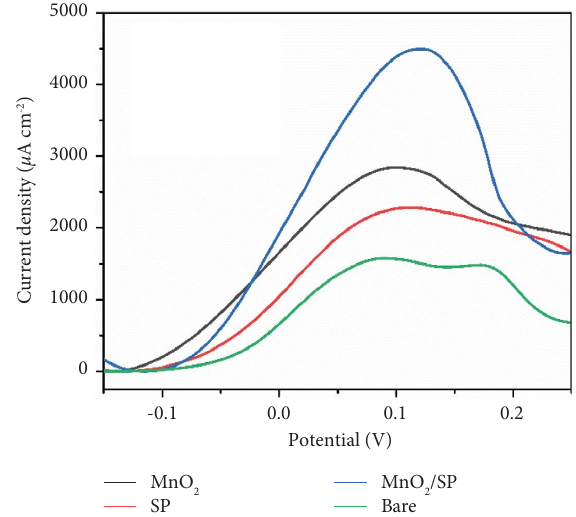
Figure 2: SWASV responses of the bare, MnO modifed SPEs chip in 0.1 M NaAc-HAc solution containing 10nM CuSO 4